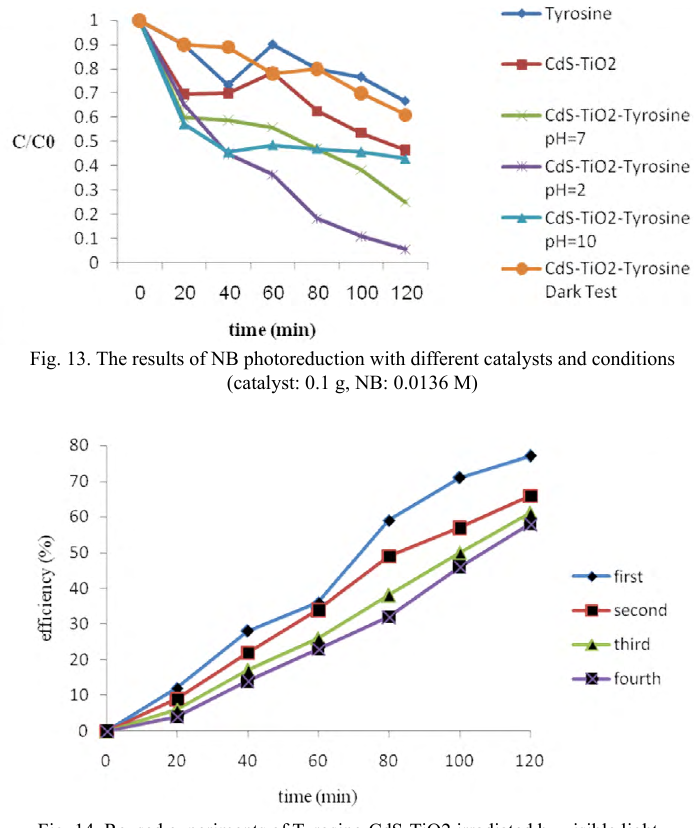
Fig. 14. Reused experiments of Tyrosine-CdS-TiO2 irradiated by visible light (catalyst: 0.1 g, NB: 0.0136 M, pH: neutral).